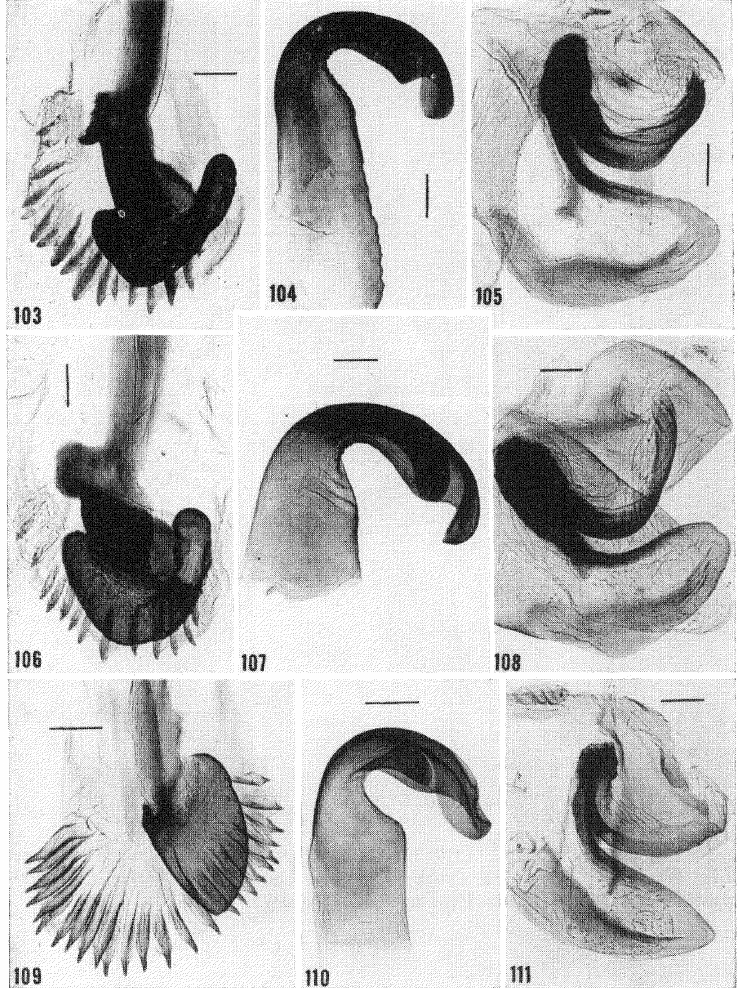
Figs. I03-111. 10:t-108. 4stiduchus borinquen. 103-105. (30 AMNH). Corozal Cave, Puerto Rico. (misidentified by Rehn and Hebard as de- tlanatus).